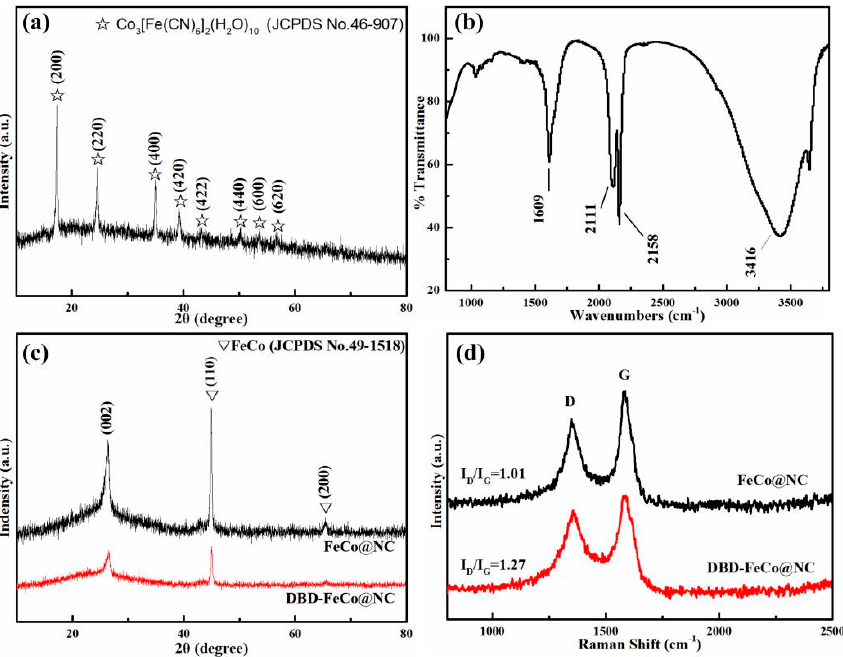
Figure 1. ( a ) XRD pattern, ( b ) FTIR spectra of CoFe-PBA, ( c ) XRD pattern, and ( d ) Raman spectra